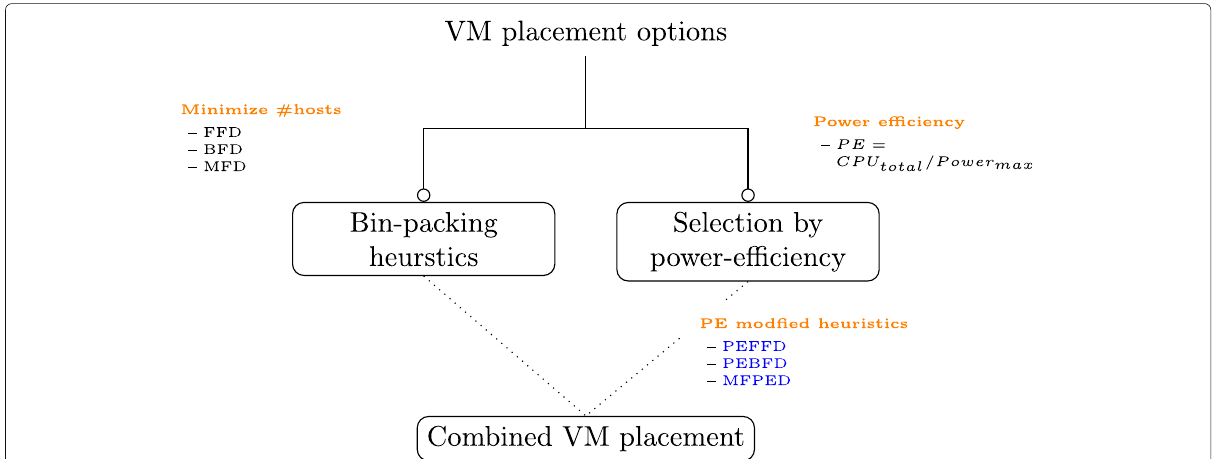
Fig. 1 Illustration of a combined heuristic. The proposed algorithms combines two VM placement heuristics: bin-packing rules and selection by